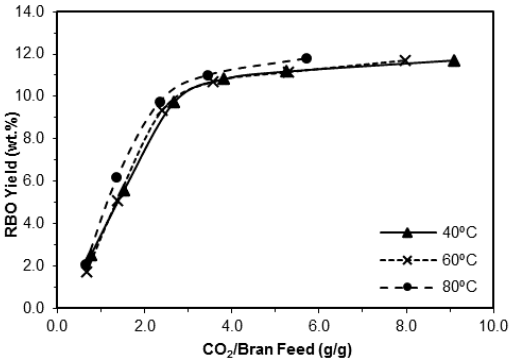
Figure 4. Supercritical fluid extraction yield of rice bran oil as a function of consumed CO 2 at different temperatures (at 40 MPa, CO 2 flow rate of 1 L/min, and using 20 g of rice bran loading).